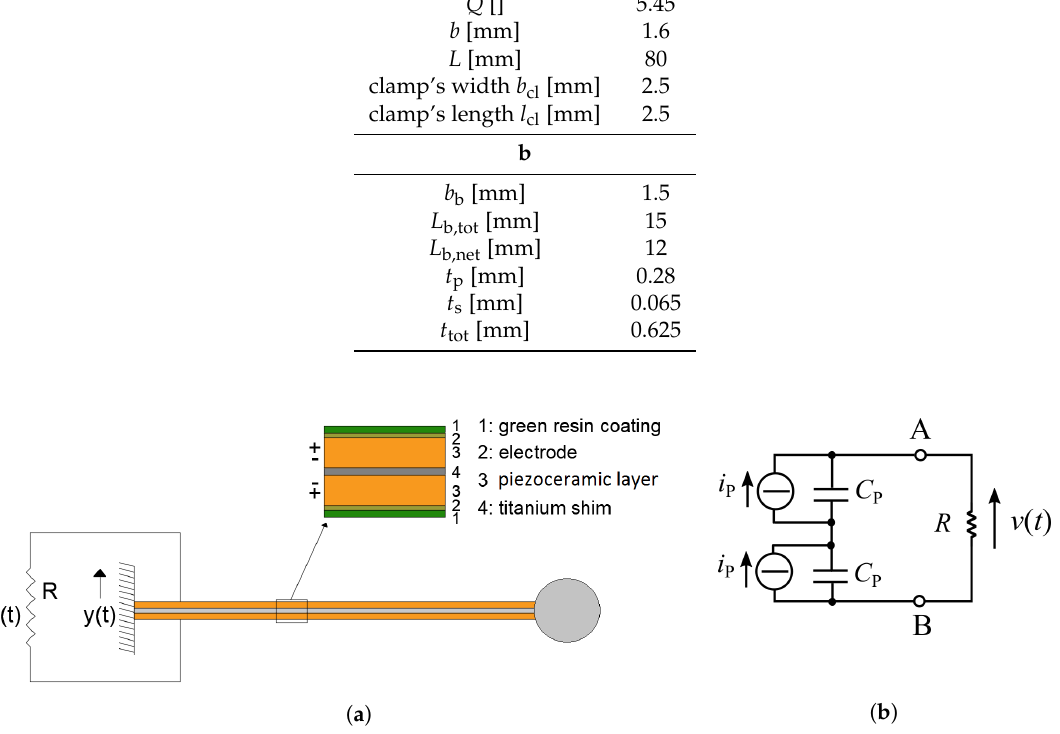
Figure 3. ( a ) bimorph cantilever beam with two piezoelectric layers electrically connected in series and ( b ) equivalent circuit of the piezoelectric